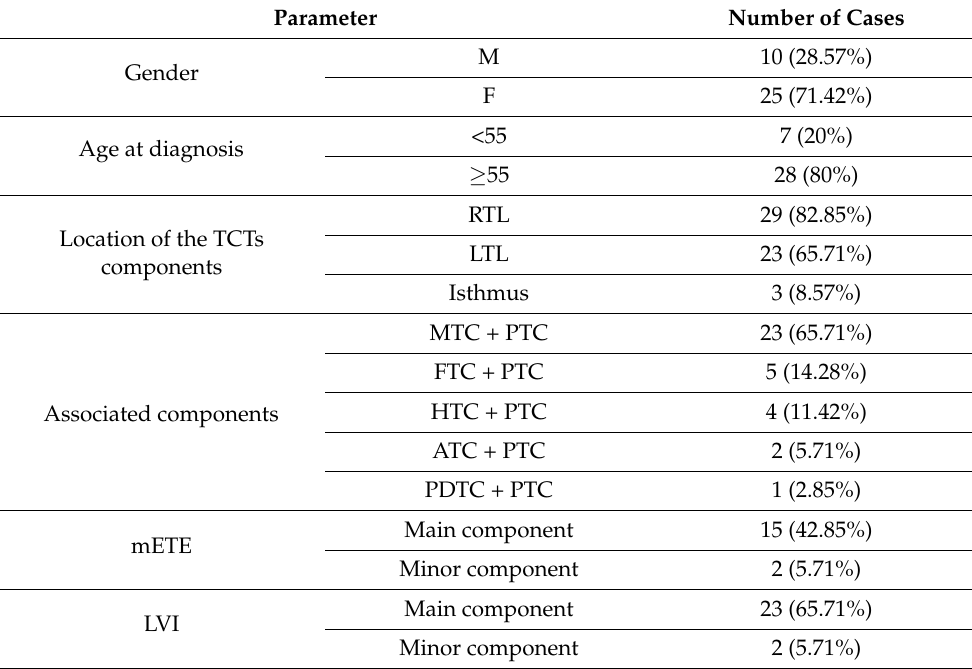
Table 1. Clinical and histopathological aspects of the TCT